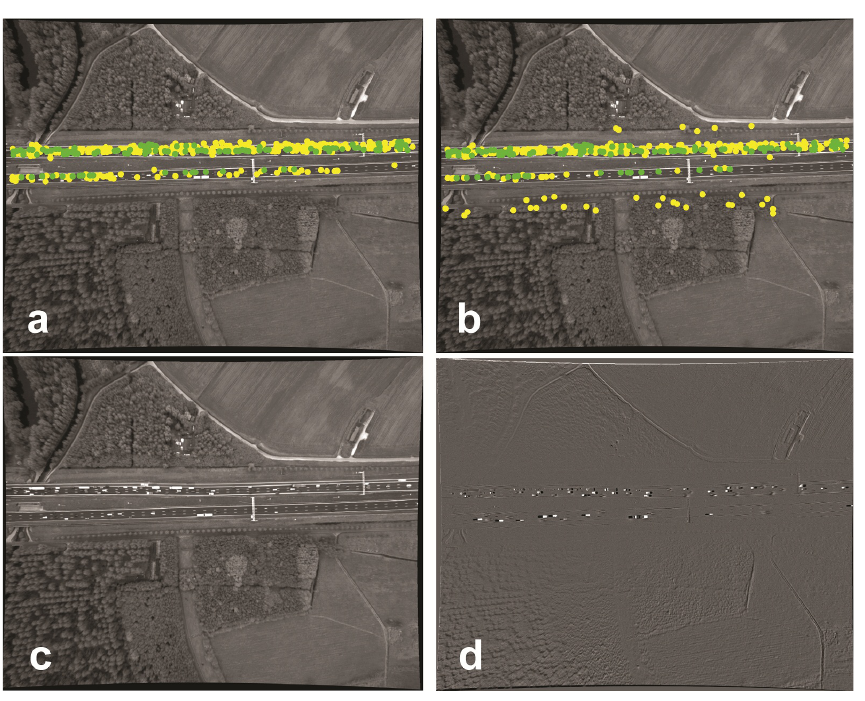
Figure 3. KLT-based matching results for registration of Image b to Image a. ( a ) The first image of the image sequence; ( b ) the second image. The point colors, yellow and green, are, respectively, the corresponding points matched by KLT (229) and the remaining corresponding points (85) suitable for the homography matrix calculation; ( c ) The transformed Image b; ( d ) the difference between Image c and Image